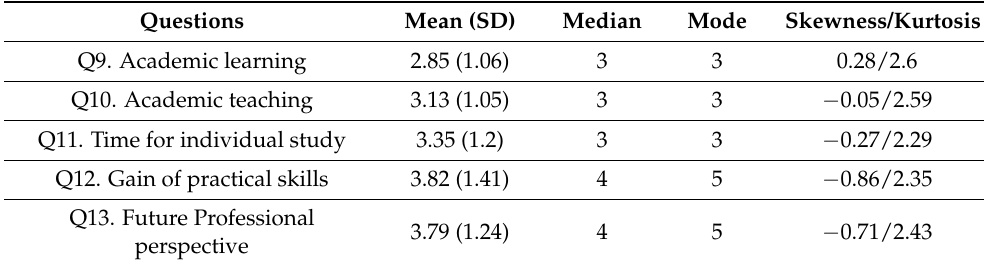
Table 4. Descriptive analysis of responses to educational impact items.